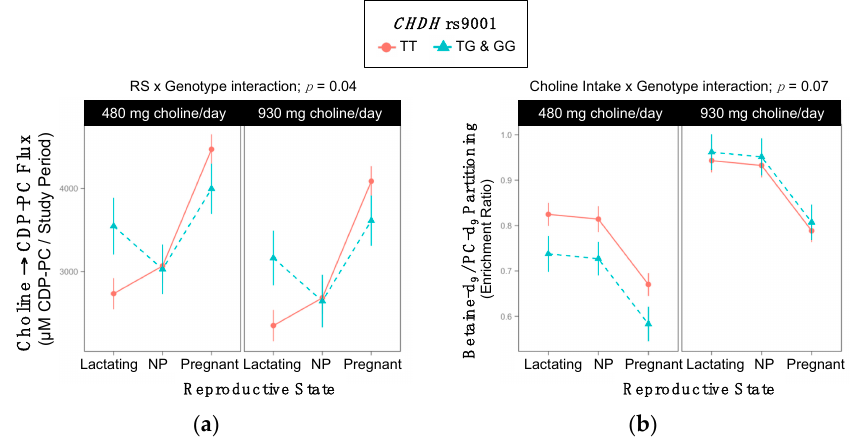
Figure 3. Effect of the CHDH rs9001 variant on the metabolic flux and partitioning of dietary choline. ( a ) Choline → CDP-PC flux; ( b ) Betaine-d 9 /PC-d 9 partitioning. In addition, genotype tended to interact with choline intake to predict betaine-d 9 /PC-d 9 enrichment ( p = 0.07) (Table 5, Figure 3b). Within the lower choline intake group, variant women exhibited lower betaine-d 9 /PC-d 9 enrichment ratios than non-variants (0.68 ± 0.03 vs. 0.77 ± 0.02 ; p = 0.06)